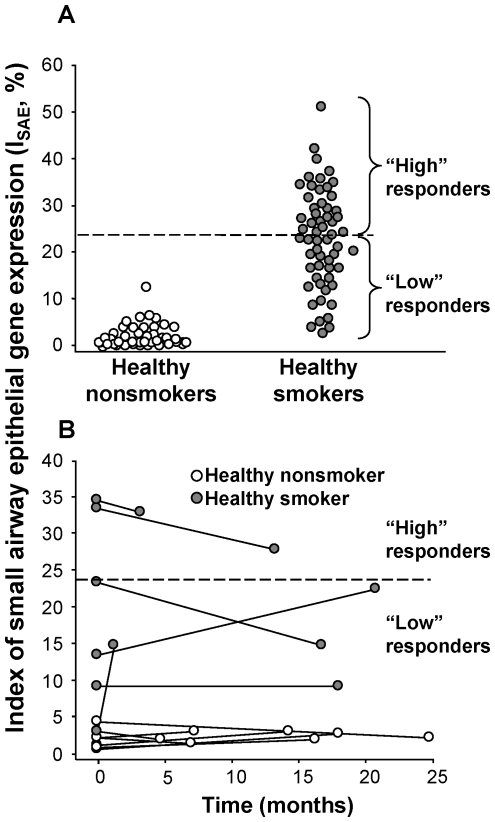
Index for small airway epithelial gene expression (ISAE).
A. ISAE values for nonsmokers (white circles, n = 47) and healthy smokers (gray circles, n = 58). The dashed line demarcates the median ISAE value for the healthy smokers. Individuals with lower ISAE demonstrate abnormal expression of relatively few smoking-responsive genes, and individuals with the highest ISAE values abnormally express the greatest numbers of smoking-responsive genes. Individuals below the median are termed “low” responders and those above the median “high” responders to the stress of smoking. B. Assessment of stability of the ISAE over time. Healthy nonsmokers (n = 7, white circles) and healthy smokers (n = 6, gray circles) had assessments of ISAE at time 0 and again at times up to nearly 25 months. All nonsmokers had ISAE values that remained <5%. Among the healthy smokers, 4 low responders remained low responders and 2 high responders remained high responders over time.